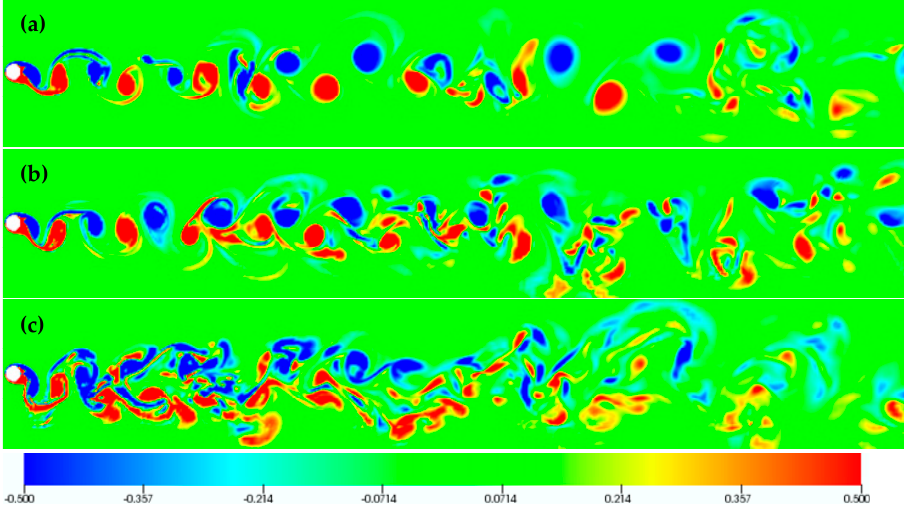
Figure 11. Counter-clockwise cylinder oscillation: Instantaneous isocontours of spanwise vorticity for the plane z = 3 for F = 0.9 and ( a ) A y /D = 0.20, ( b ) A y /D = 0.30, ( c ) A y /D = 0.60.